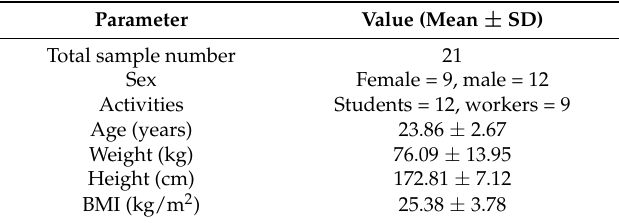
Table 1. Demographic information of study